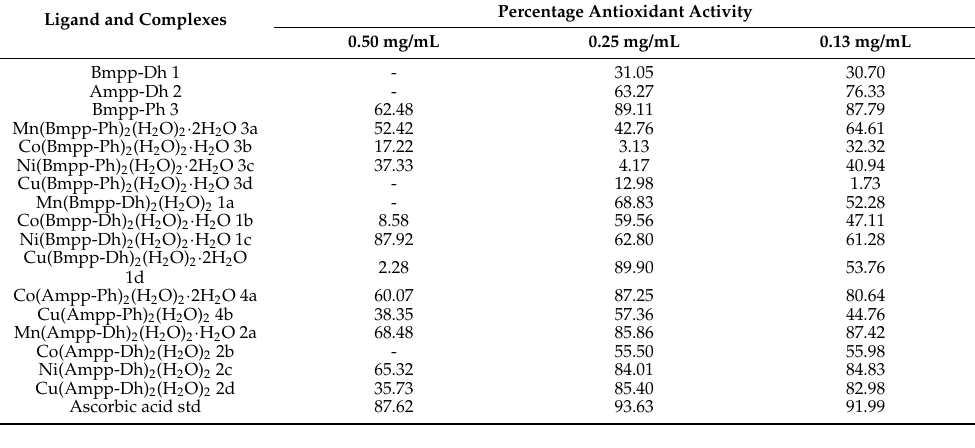
Table 3. Antioxidant scavenging activity data of 2,4-dinitrophenylhydrazones and their metal complexes (%).